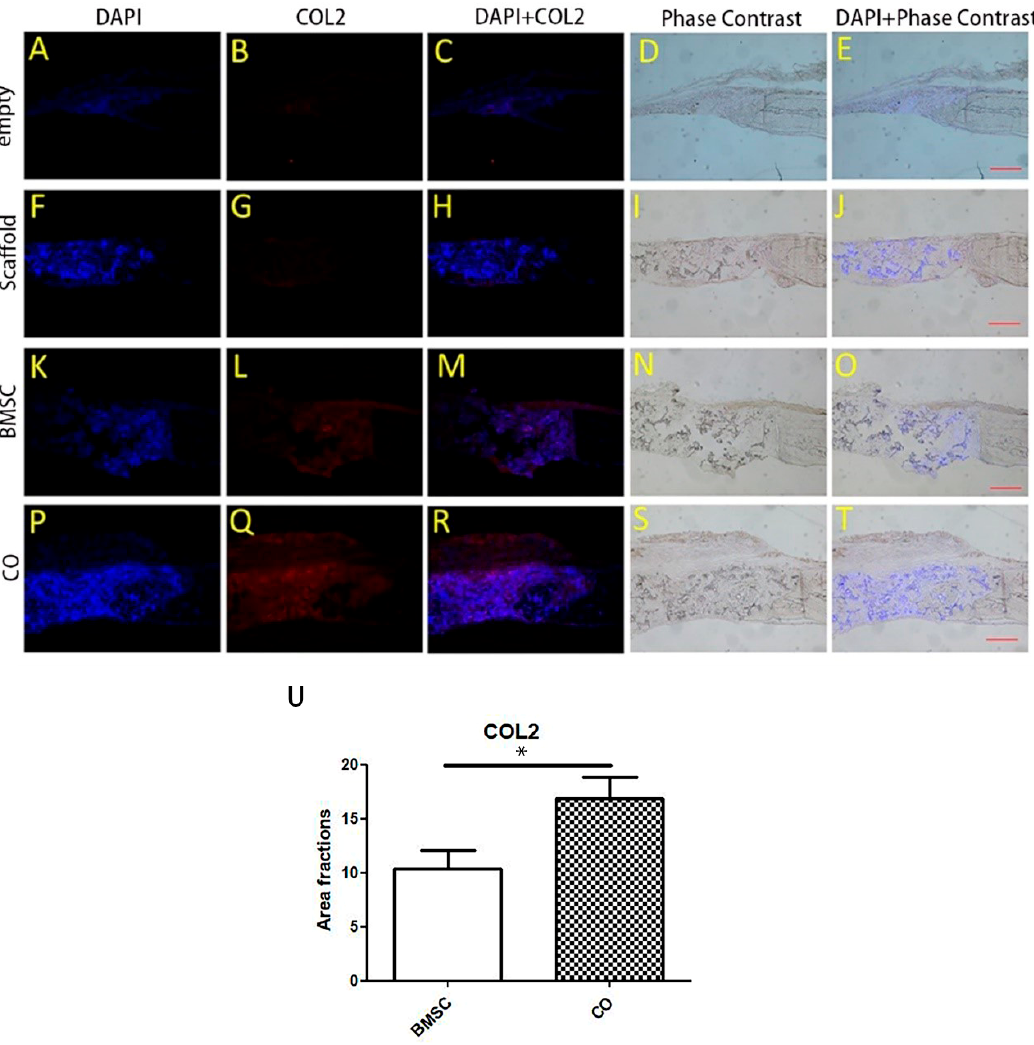
Figure 4. Immunofluorescence analysis for collagen type II in graft areas. Positive staining areas of collagen type II could be observed in both BMSC ( L ) and CO group ( Q ). In descending order: 1st row: images ( A – E ) of the empty group, 2nd row: images ( F – J ) of the Scaffold group, 3rd row: images ( K – O ) of the BMSC group, 4th row: images ( P – T ) of the CO group. General images ( D , E , I , J , N , O , S , T ) were observed by phase contrast microscope to show the overview of sections from different groups, and the remaining images were observed by fluorescence microscope to show collagen type II expression. Scale bar: 100 µ m. ( U ) Area fraction of positive immunofluorescence of collagen type II in the CO and BMSC group was evaluated, and the area fraction of the CO group was more than that of the BMSC group (n = 8, * p < 0.05).